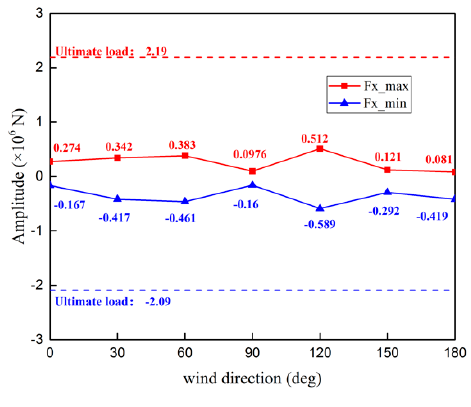
Figure 8. Fx of tower.